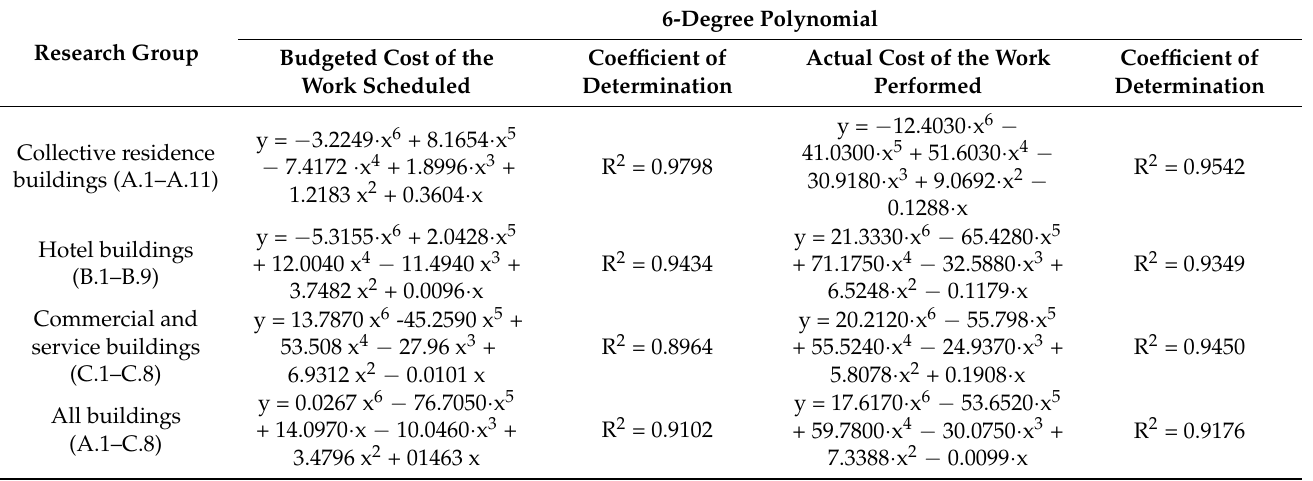
Table 3. A 6-degree polynomial describing the shape of the cost curve (best fit).